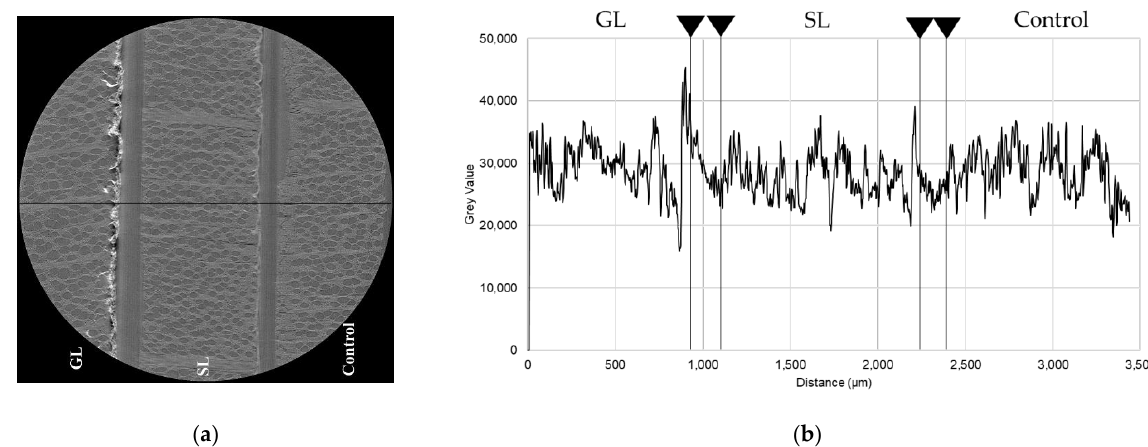
Figure 5. Sample series 1 Cu target up side (GL, SL, control); ( a ) visualization result and the plot profile line; ( b ) plot profile graphic.